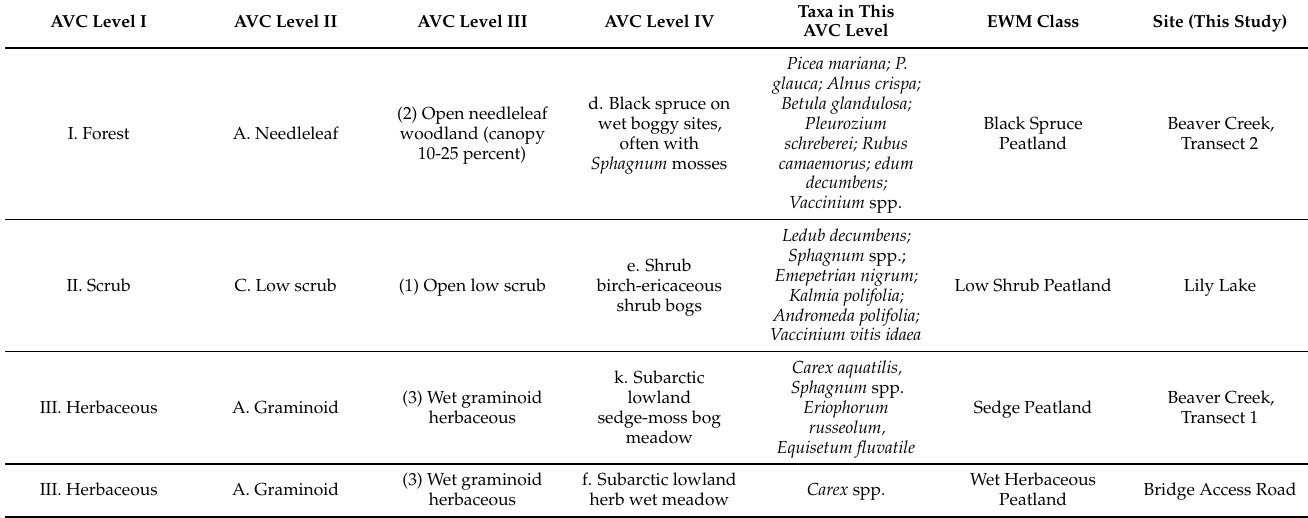
Table A1. Comparison between the Alaskan Vegetation Classification (AVC, [27] of the sampled wetland-peatlands and the Existing Wetland Map [21]. For full detail see [27].